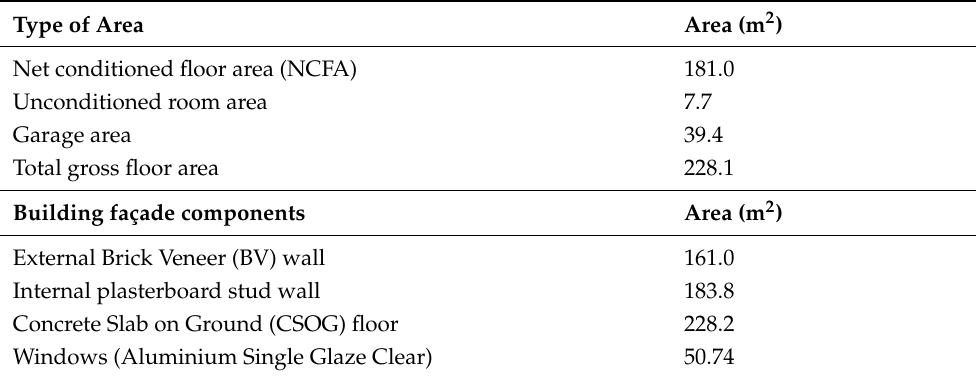
Table 1. Conditioned and unconditioned areas to estimate operational